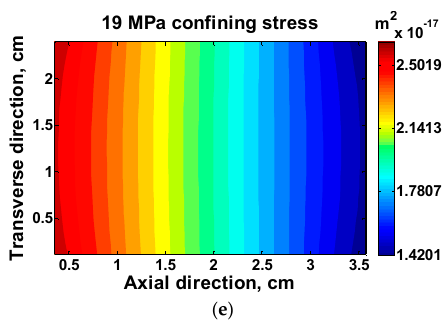
Figure 8. 1D and 2D spatial distributions of permeability in sample LS1-16-1. ( a ) 1D distribution of permeability; ( b ) 1D distribution of derivative of permeability; ( c ), ( d ) and ( e ) are 2D distributions of permeability with confining stress 13 MPa, 16 MPa and 19 MPa respectively.